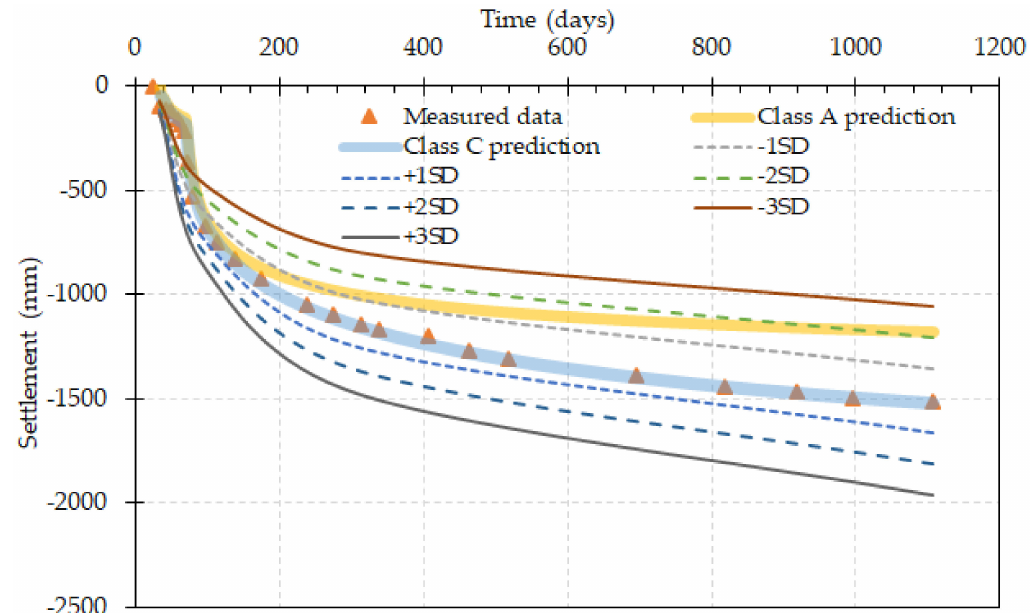
Figure 11. Measured and Predicted settlement for mean ± 1SD, ± 2SD and ± 3SD for Ballina clay. From Figures 11 and 12, Class A prediction of Karakore and Ballina was found to be close to the best estimate of mean—3SD and mean—2SD, respectively. The predicted settlement of Karakore clay using the laboratory input parameters at the end of observation was found to be 428.4 mm as LB values, whereas the UP was 795.6 mm. This shows that the prediction was found within a 99.73% confidence interval of all values. Whereas, Ballina clay, the LB predicted value was 1209.2 mm, whereas the UB was 1814.4 mm, which is all values laid within a 95% confidence